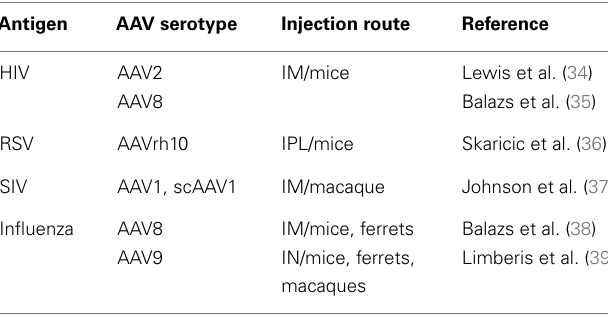
Table 2 | Summary of passive immunization studies usingAAV vectors